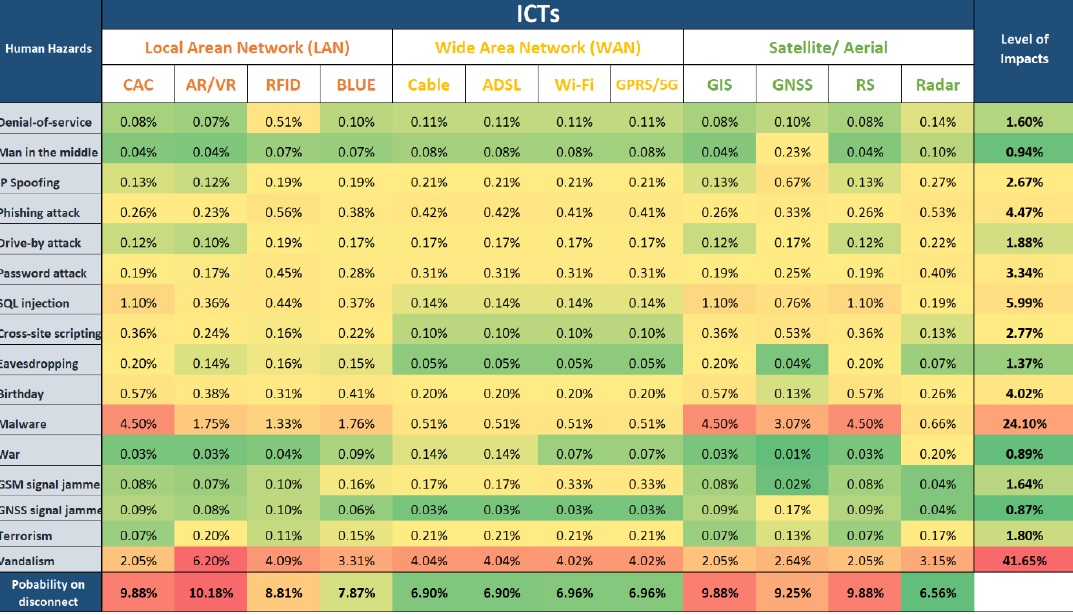
Figure 8. The impacts of man-made hazards on ICTs.